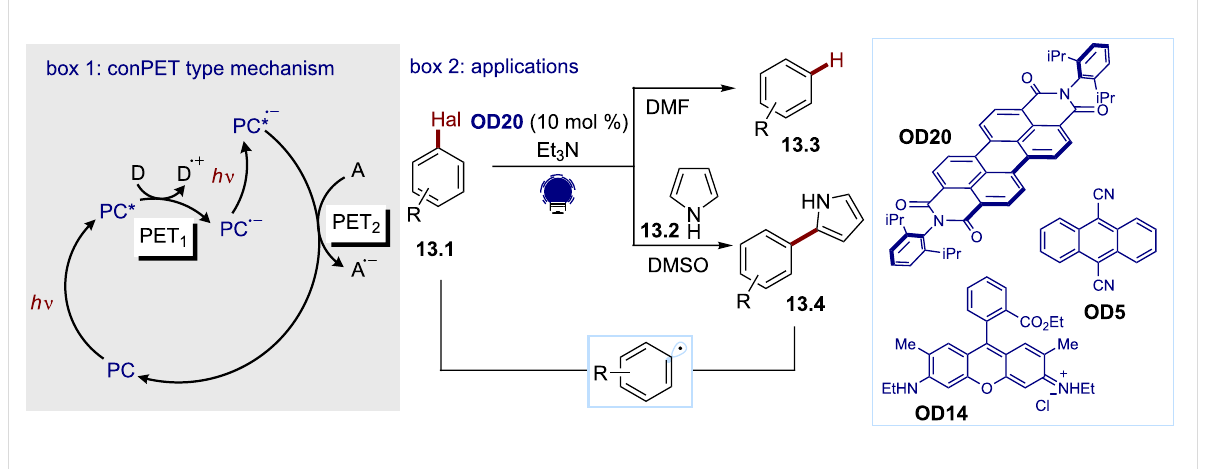
Scheme 13: Illustrative example for the photocatalytic reductive generation of aryl radicals from aryl halides using a conPET strategy. Box 1: conPET mechanism and box 2: the dehalogenation and heteroarylation of aryl radicals reported by König and co-workers